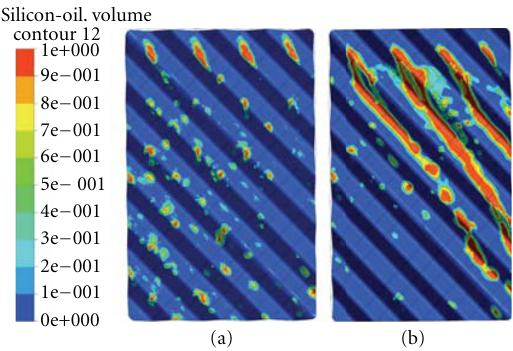
Figure 21: Wetted area on the bottom packing for two inlet posi- tions. (a) Position 1. (b) position 2. Vol. Flow rate = 811mL/min.